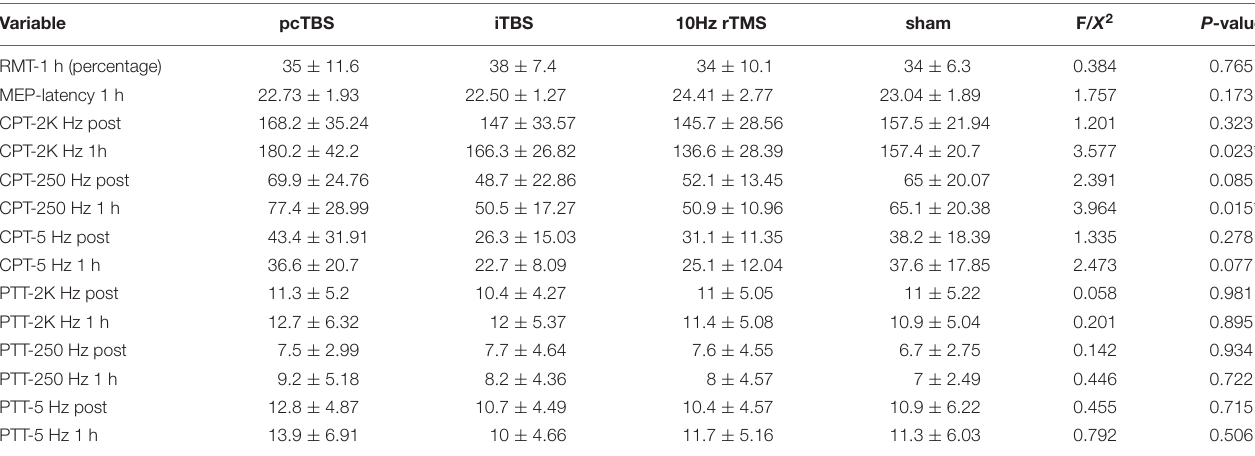
TABLE 2 | Comparison of outcomes in the four groups in post-stimulation and 1 h after